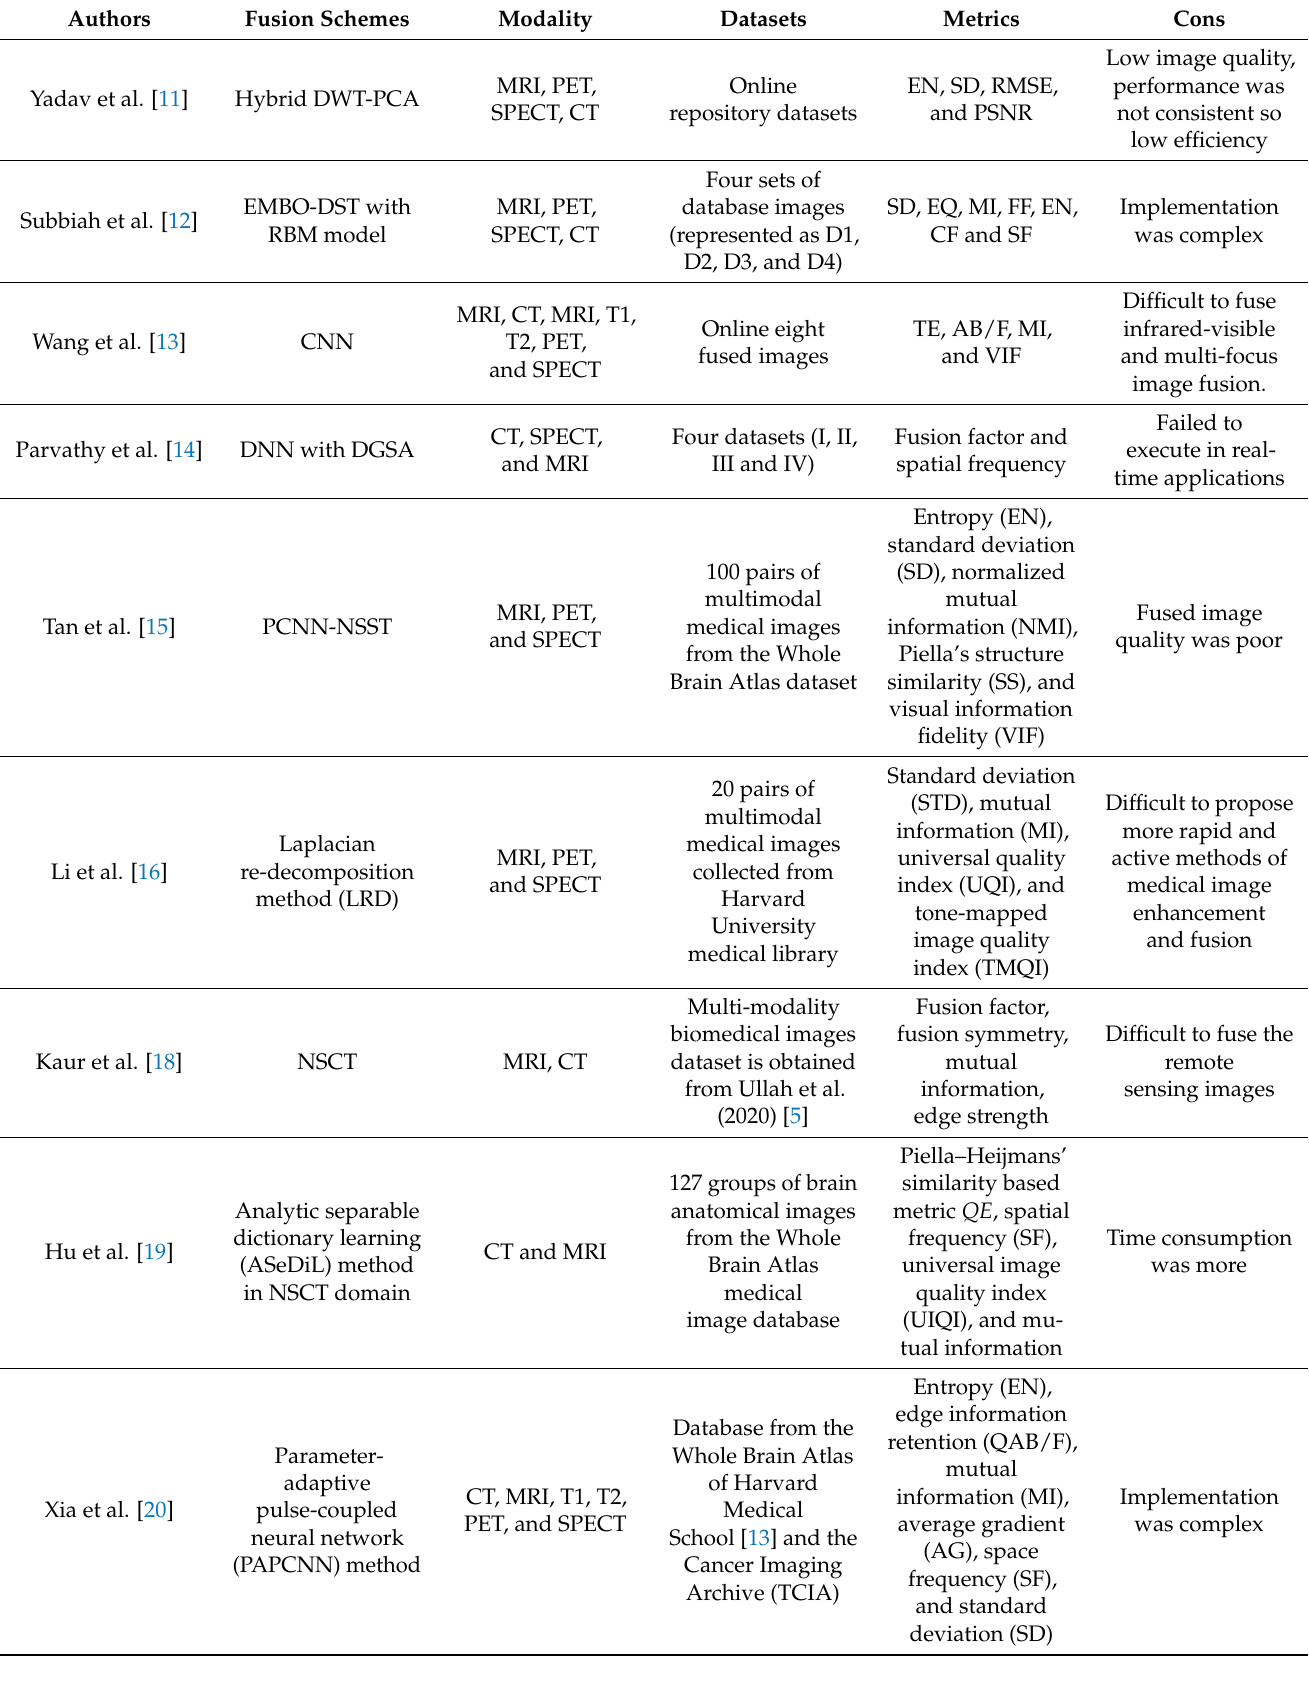
Table 1. Summary of related works regarding multimodal medical image